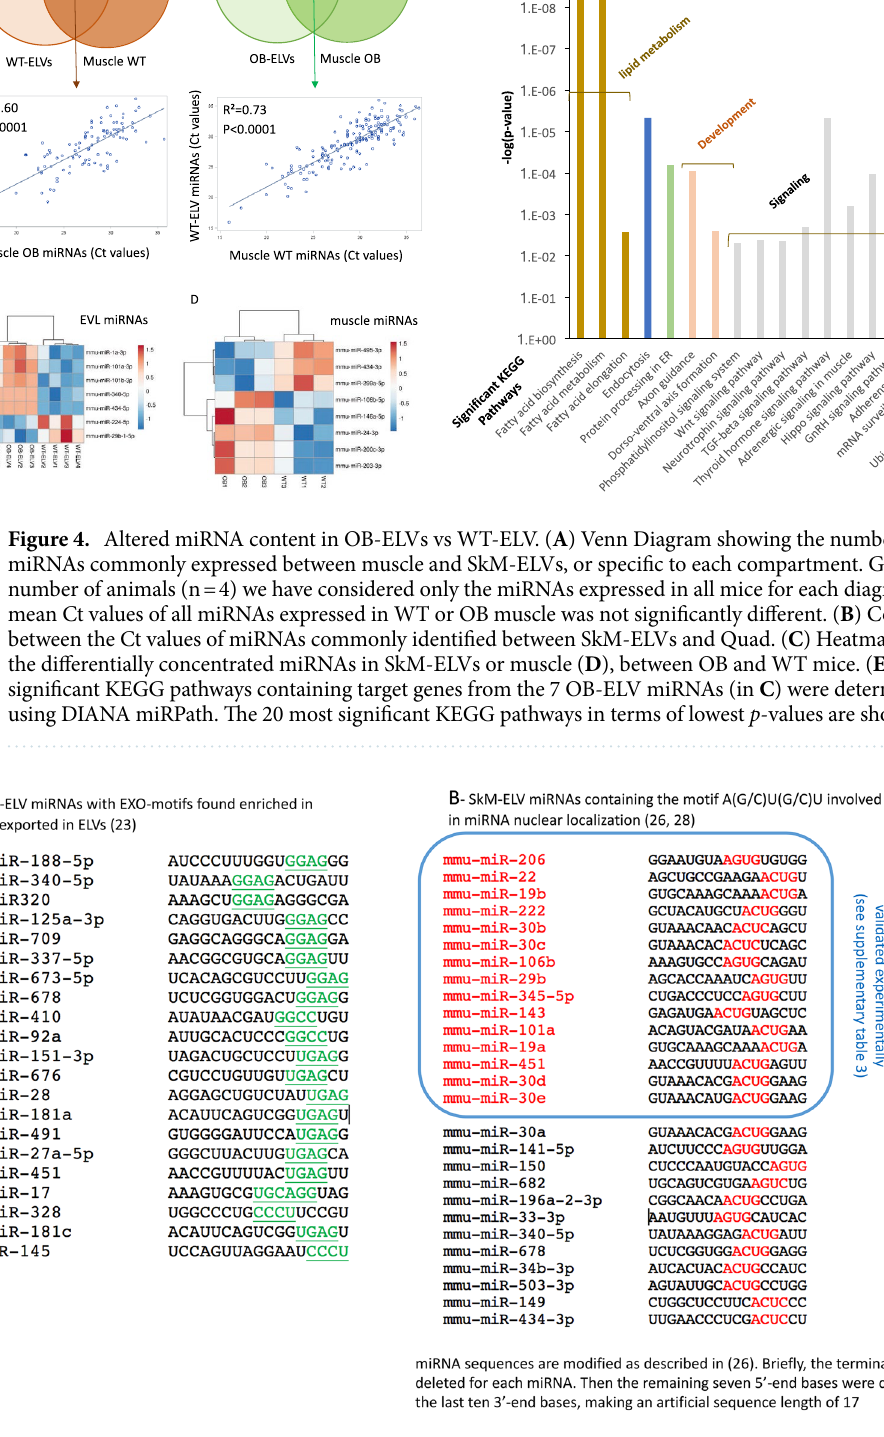
Figure 5. Sequence analyses of exported miRNA in SkM-ELVs. ( A ) SkM-ELV-miRNAs with EXO-motifs 23 . ( B ) Detailed procedure to identify the A(G/C)U(G/C)U sequence associated with miRNA nuclear localization. Only miRNAs contained in SkM-ELVs with this sequence are shown 26,28 . Validated miRNAs are indicated in red and the associated publications are mentioned in supplementary Table